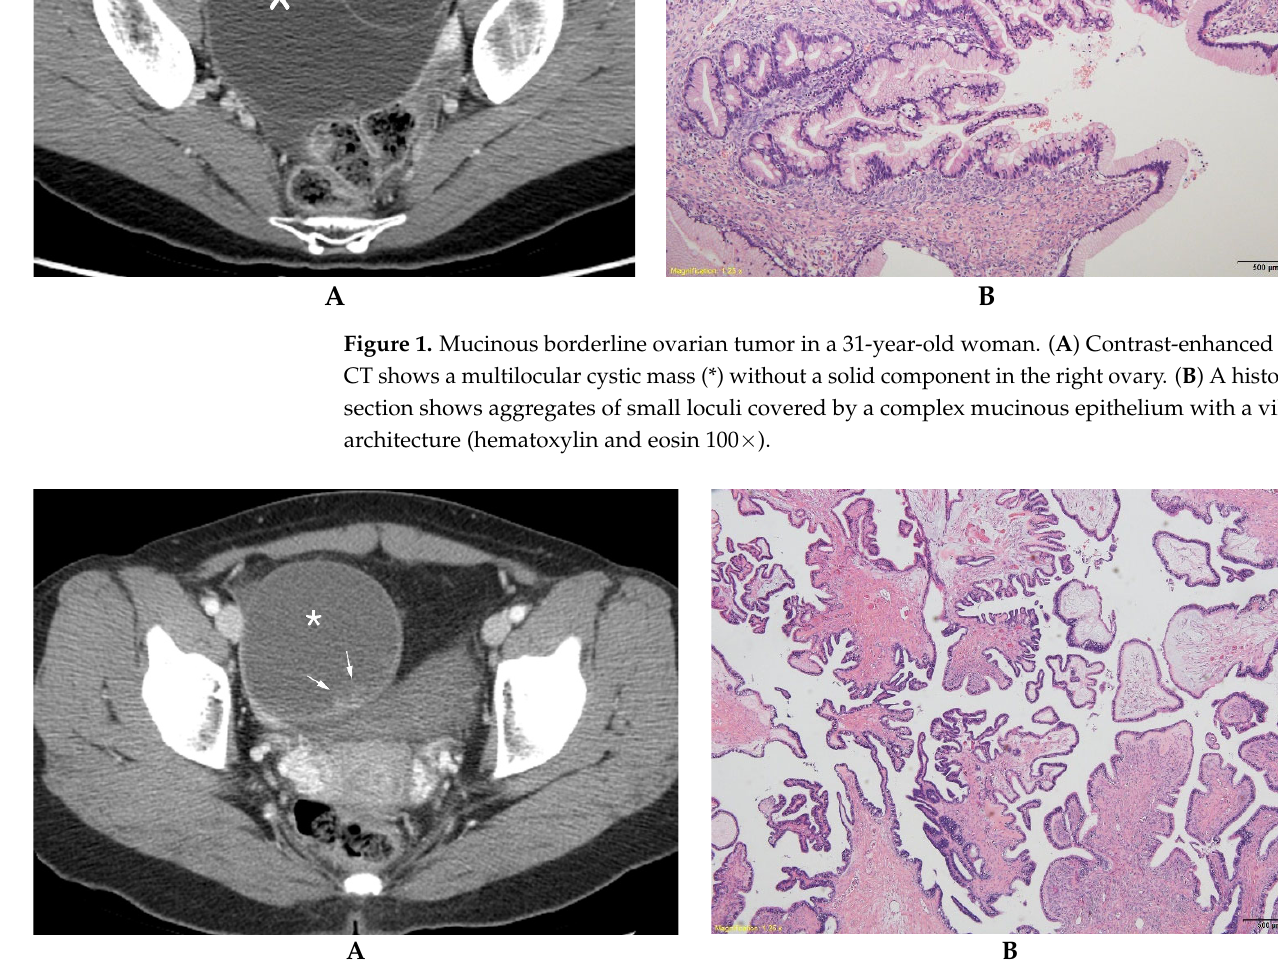
Figure 3. Serous ovarian carcinoma in a 44 ‐ year ‐ old woman. ( A ) Contrast ‐ enhanced axial CT shows a unilocular cystic mass with well ‐ defined multiple solid components (arrows) in the right ovary. ( B ) A histologic section shows malignant glands of varying shapes and sizes infiltrating the stroma (hematoxylin and eosin 100×).